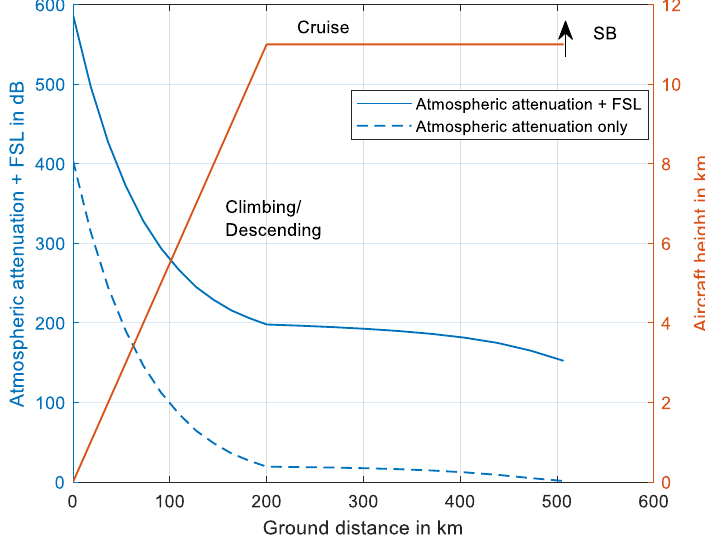
Figure 13. Flight signal attenuation performance at 66 GHz 5G mm-wave frequency.